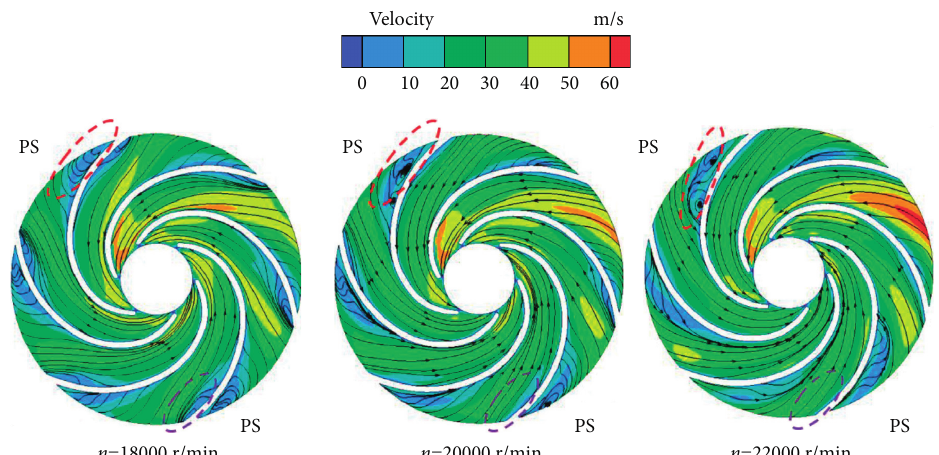
Figure 14: Streamline and velocity distribution in the impeller passage.